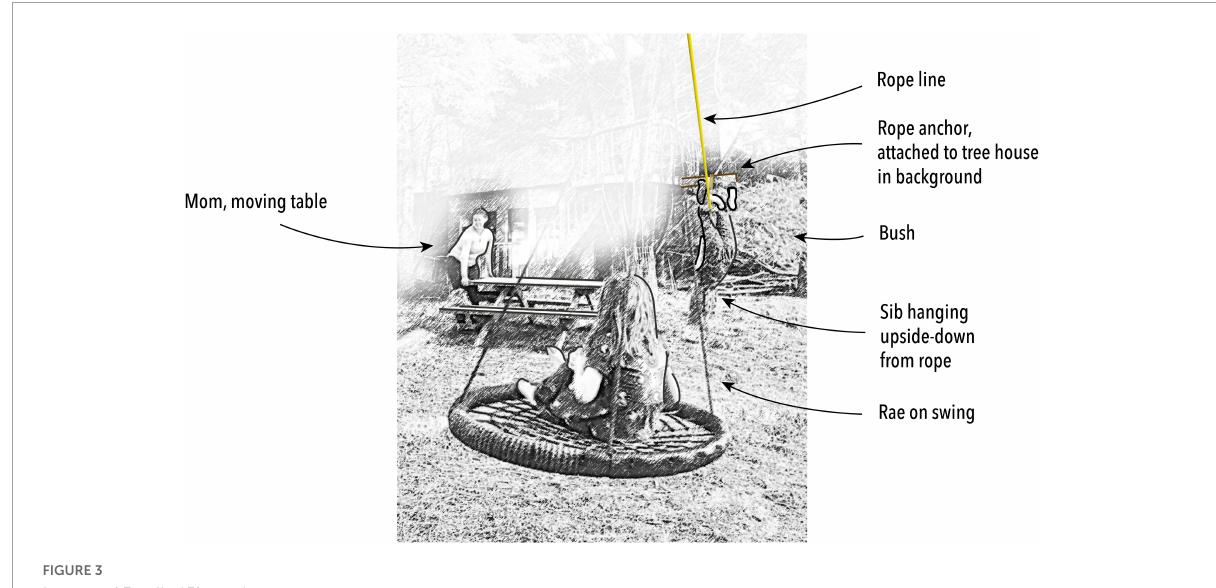
FIGURE3 Layout of Family 15’s yard